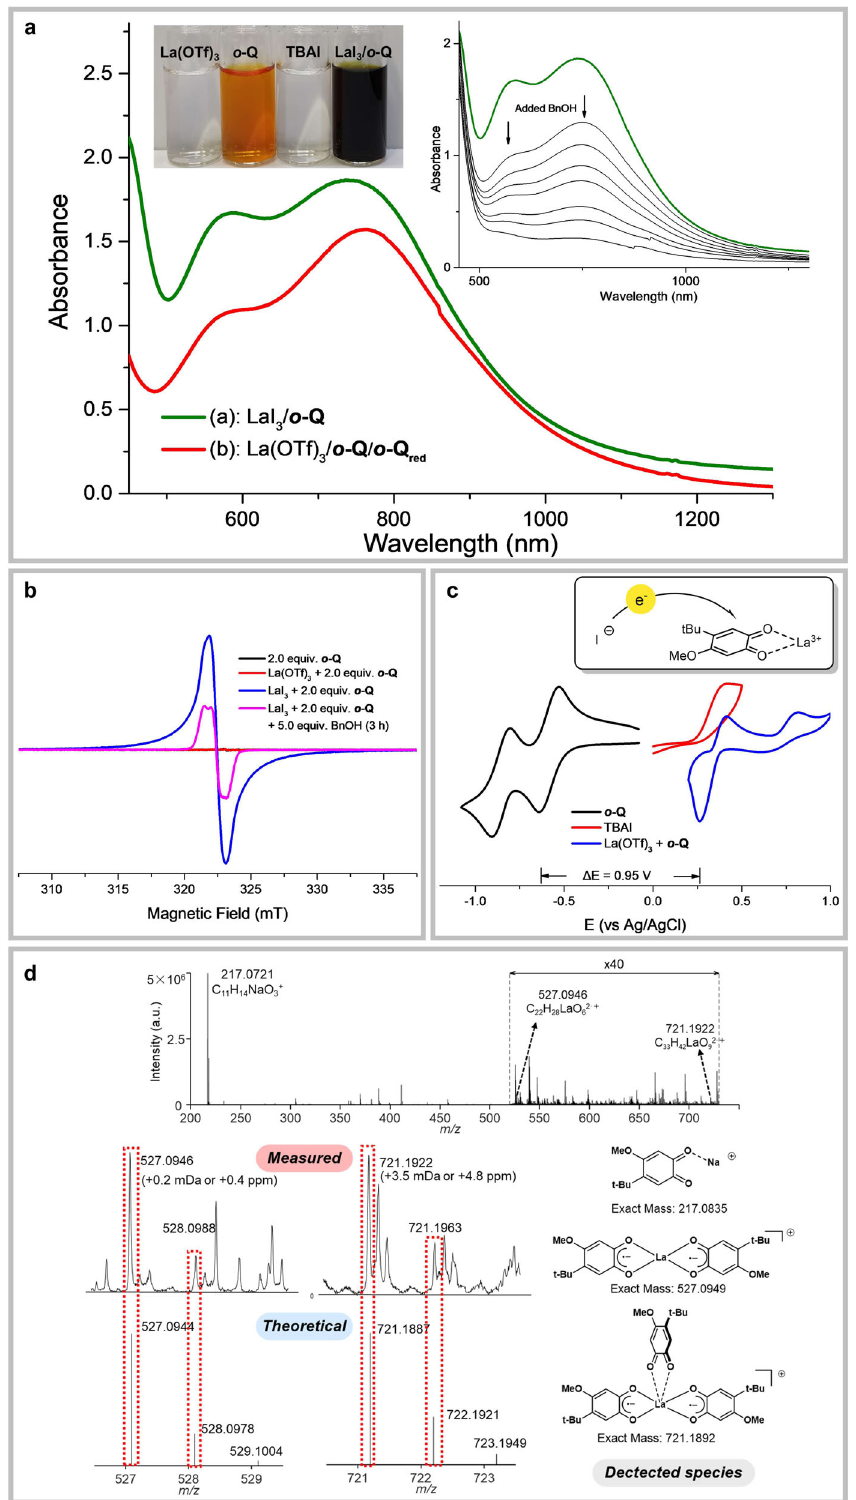
Fig. 6 Characterization of active species. a UV – Vis spectrum. Sample concentration: 1.0 mM in MeCN. ( a ): LaI 3 (1.0 mM) and o -Q (2.0 mM); ( b ): La(OTf) 3 (1.0 mM), o -Q (1.0 mM), o -Q red (1.0 mM), DBU (2.0 mM). Inset: The time pro fi le of stoichiometric benzyl alcohol quenching experiment. (Supplementary Fig. 5). b EPR spectrum. Sample concentration: LaI 3 (0.1 M) and o -Q (0.2 M) in MeCN at 298 K. c CV test. Sample concentration: 4.0 mM in electrolyte solution (0.1 M nBu 4 NPF 6 in MeCN). d High-resolution mass spectrum of LaI 3 and o -Q in MeCN at 298